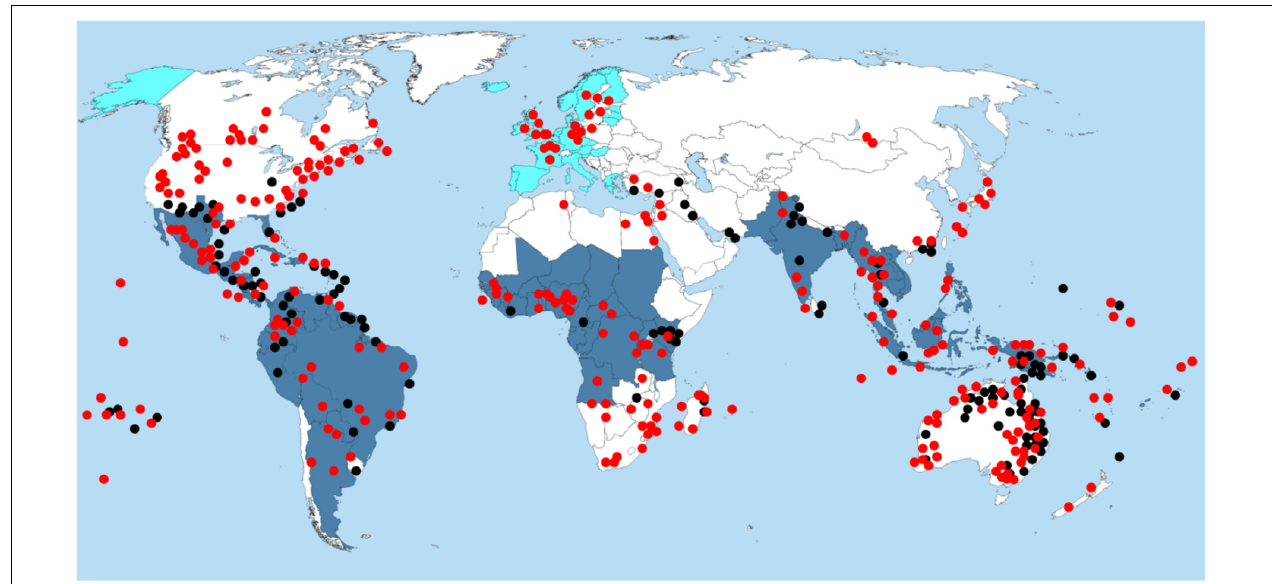
FIGURE 2 | Distribution of Aedes and Culex mosquito species and diagnosis of ZIKV infection. Red dots, distribution of Aedes species; Black dots, distribution of Culex species; Dark blue area, regions where ZIKV infection was diagnosed; Light blue area, regions where travel related ZIKV infection were diagnosed.